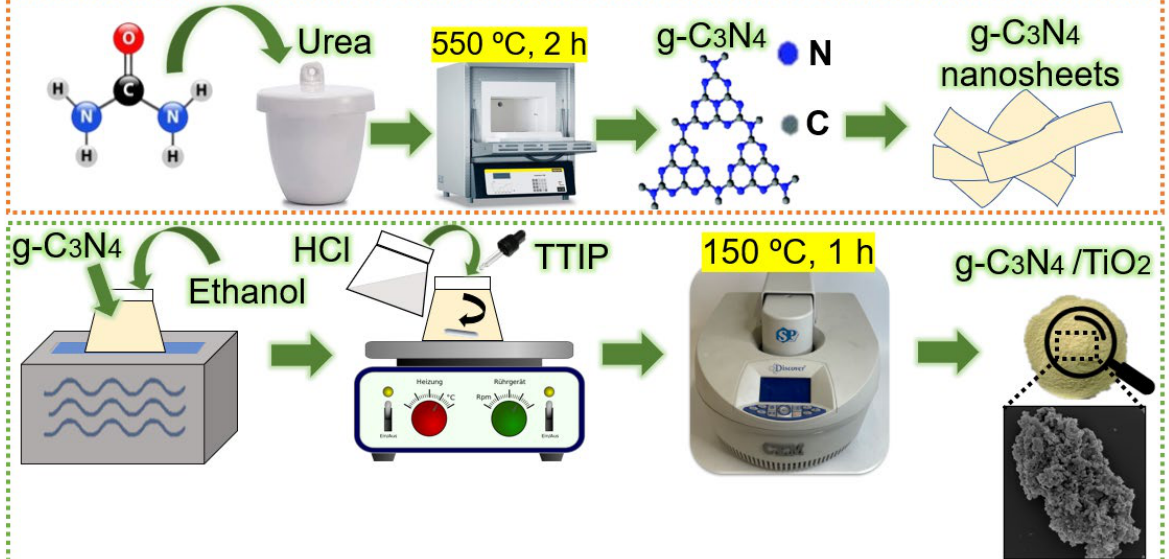
Figure 1. Schematic diagram for the microwave synthesis of g-C 3 N 4 /TiO 2 heterostructures. The schematic in the orange box represents the first steps for the synthesis of g-C 3 N 4 /TiO 2 heterostructures, while the schematic in the green box represents the last steps for the synthesis of g-C 3 N 4 /TiO 2 heterostructures.